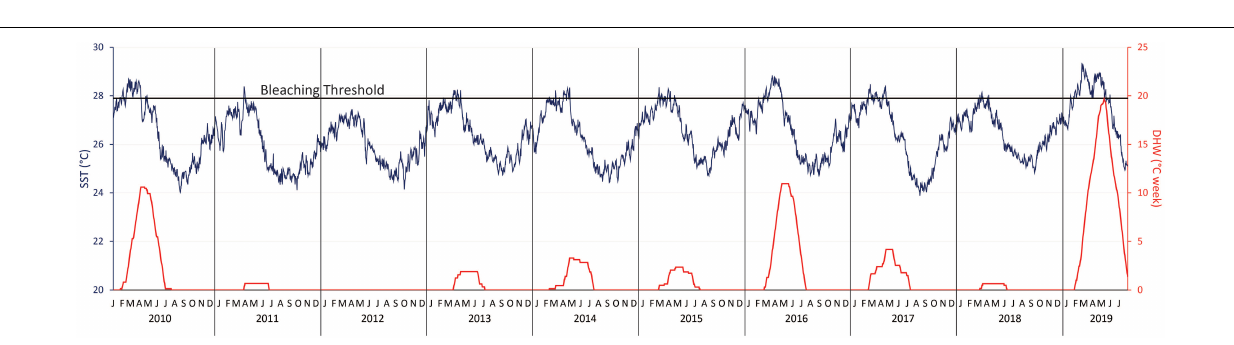
FIGURE 1 | Map of study areas. Samples were collected from the Coroa Vermelha reefs and Pedra do Silva and Virada de Fora reefs within the Itacolomis Reef Complex from June 25, 2019 to July 5, 2019. The Itacolomis Reef Complex is in the protected Marine Extractive Reserve of Corumbau.